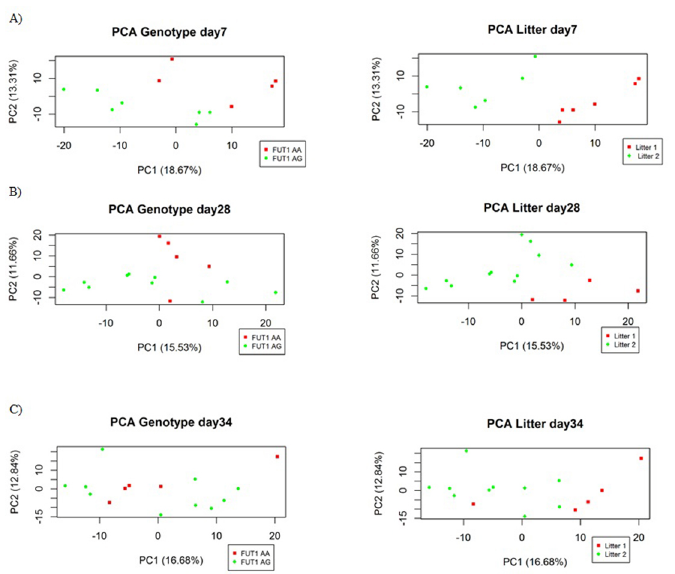
Fig 2. PCA Score plot of FUT1 genotype and litter differences during suckling, weaning, and after weaning. A) : Score plot of plasma metabolites on day 7. PC1 and PC2 explain 18.67% and 13.31%, respectively; B) Metabolomics s core plot on day 28 (weaning), PC1 = 15.53% and PC2 = 11.66%. C) PCA score plot after weaning (day 34), where PC1 and PC2 explain 16.68% and 12.84% of total variance,